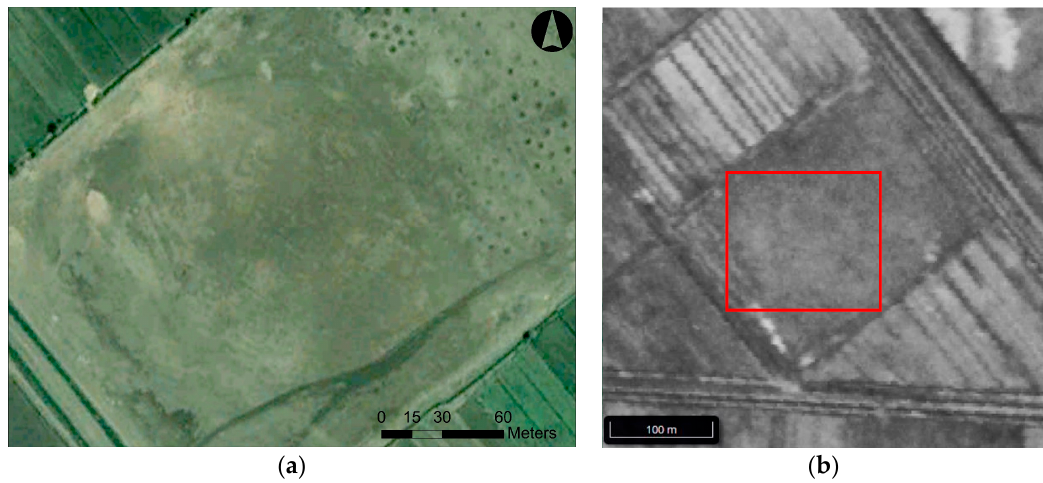
Figure 24. ( a ) The site of Umm el-Lahm Image courtesy Google Earth; ( b ) 1968 CORONA image. The area of image ( a ) is in the red box. Image courtesy of the Center for Advanced Spatial Technologies, University of Arkansas/U.S. Geological Survey.